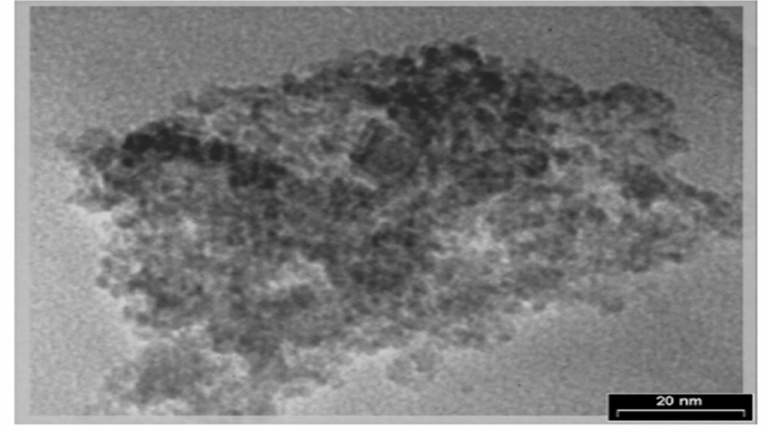
Figure 4. A TEM image of chitosan nanoparticles [67].